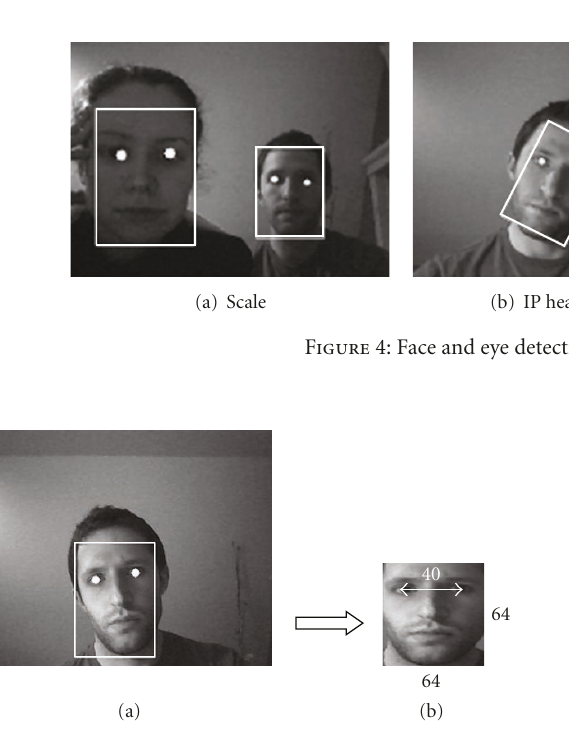
Figure 5: Face alignment and masking to: (a) Original frame, (b) Aligned and masked face ready to be analyzed (dimensions shown for illustrative purposes).